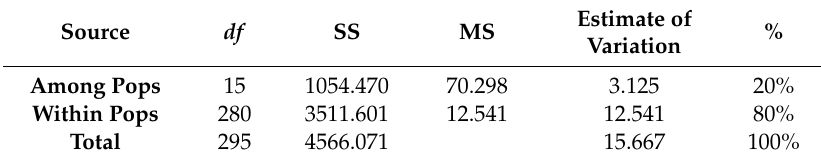
Table 5. Analysis of molecular variance (AMOVA) of bermudagrass of di ff erent population.